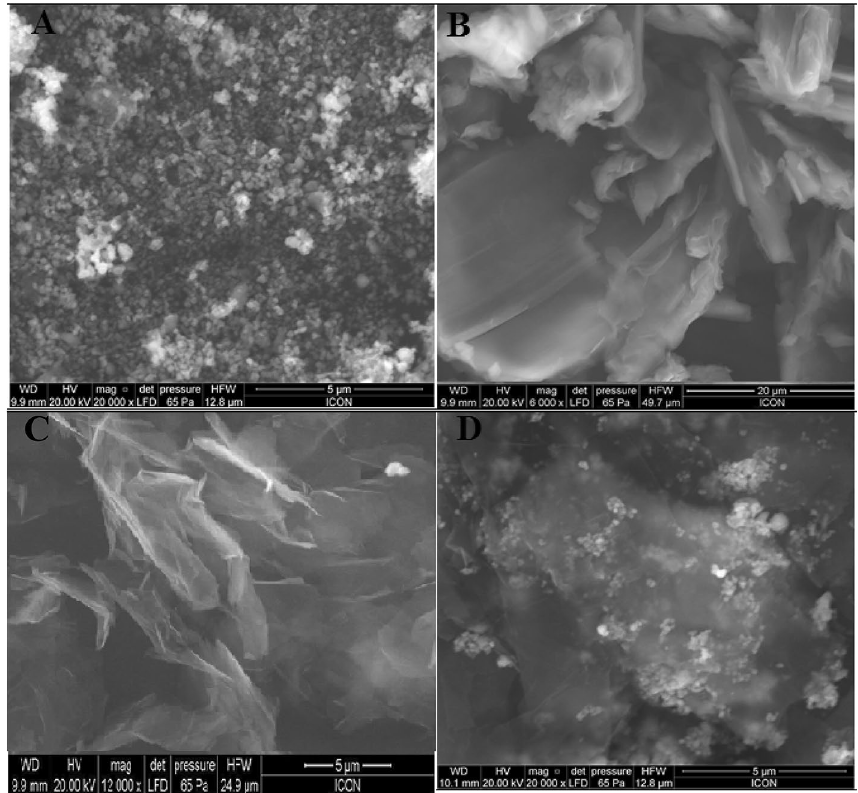
Figure 2. Scanning electron microscopic images of ( A ) ZnO NPs, ( B ) GO, ( C ) GN and ( D ) GN:ZnO